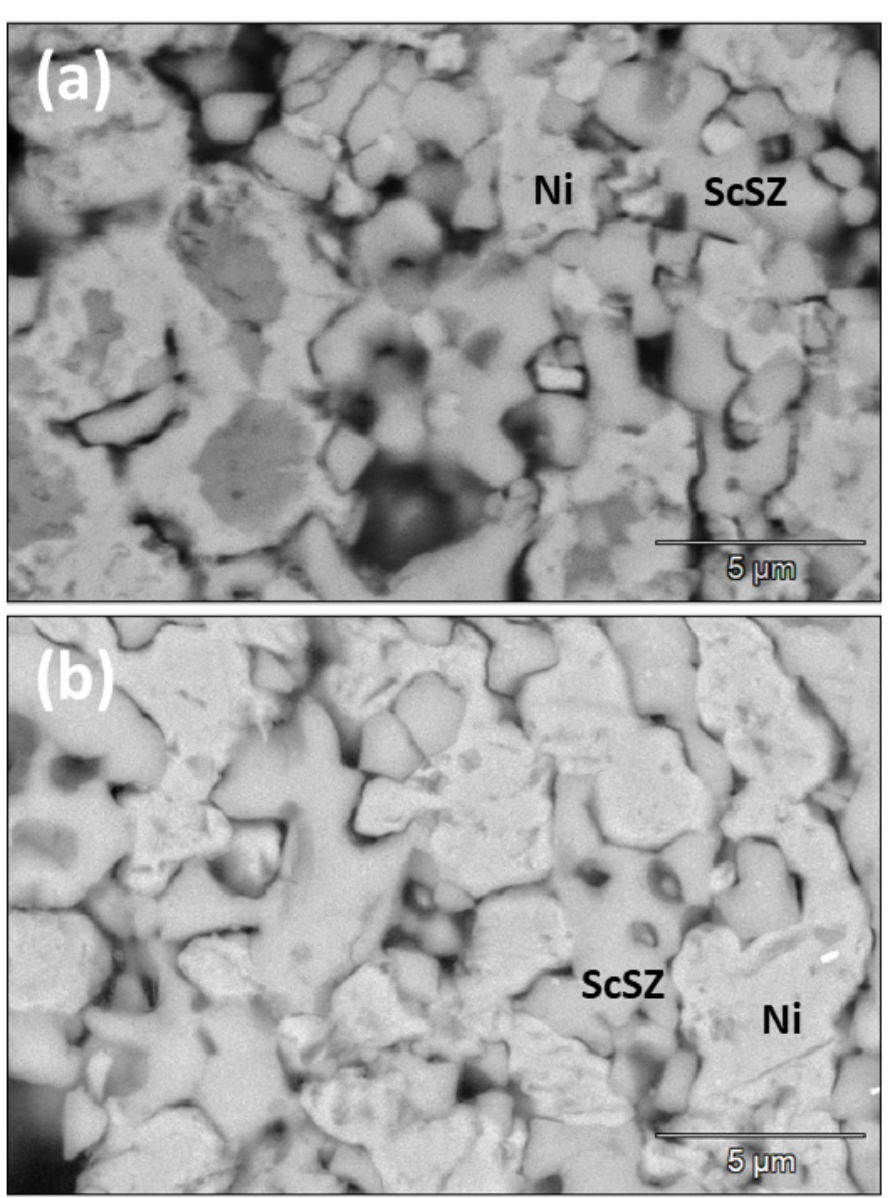
Figure 11. Ni-ScSZ particles of the fuel electrode functional layer ( a ) before the stability test and ( b ) after the stability test, showing the coarsening of the Ni particles.